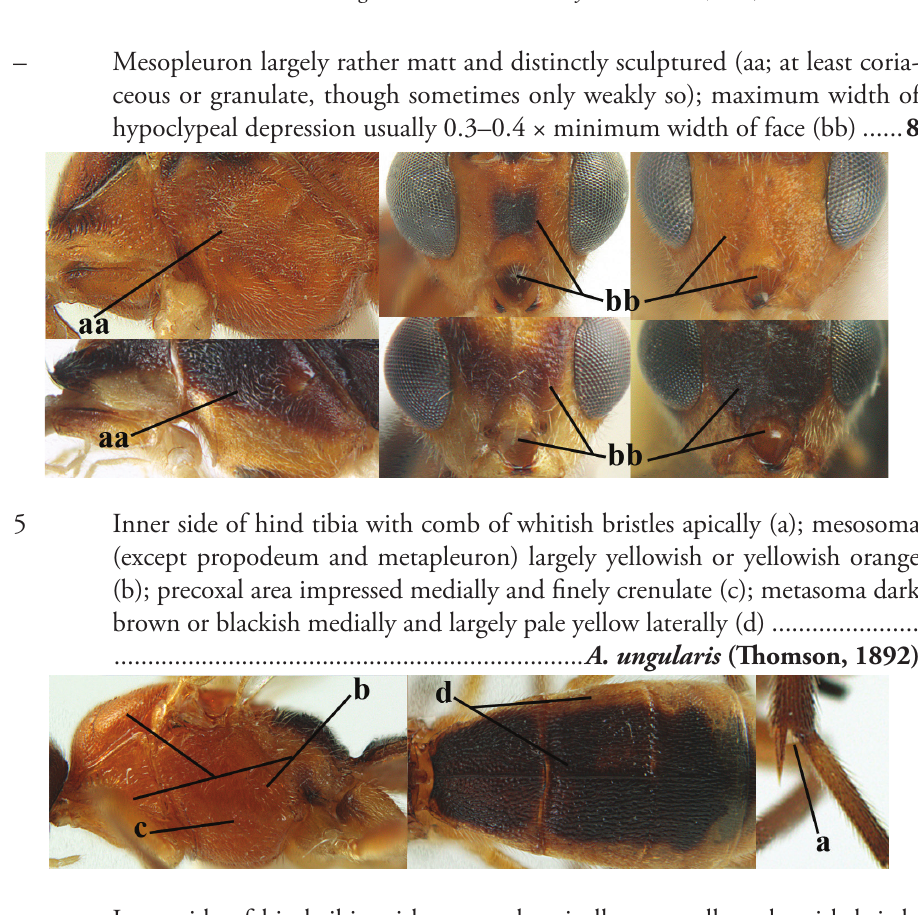
– Inner side of hind tibia without comb apically, normally only with bristly setae (aa); mesosoma largely black (bb) except in A. testaceus ; precoxal area not impressed and smooth (cc) or rugose (ccc); metasomal tergites practically completely yellowish (dd) or brownish (in A. albitibia sometimes with a large yellow or ivory central patch on second tergite), if blackish or dark brown then also laterally so (ddd) ..........................................................................